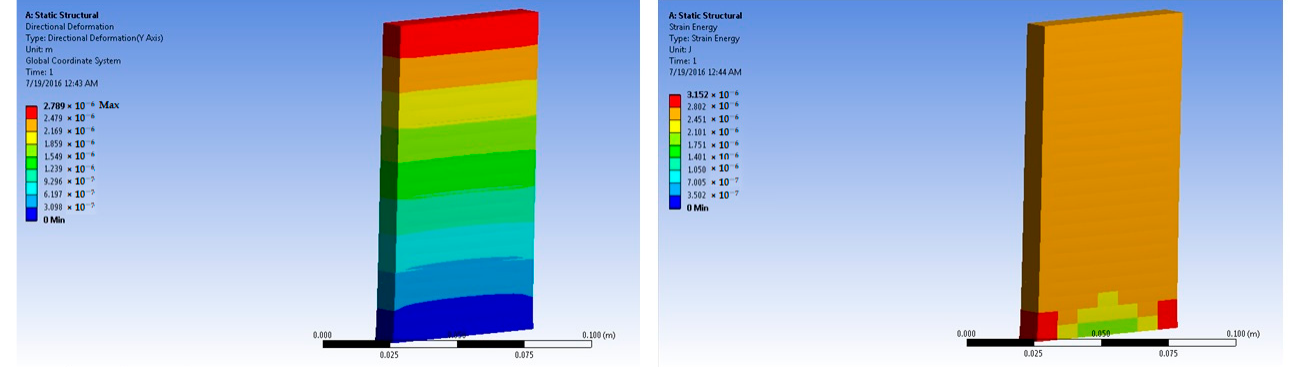
Figure 14. One percent basalt-fiber-reinforced concrete slab at 300 × 10 5 N force (deformation and strain energy).